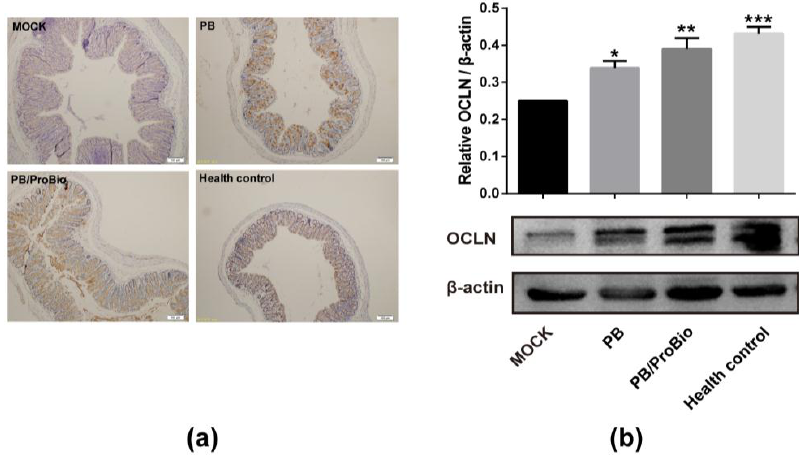
Figure 5. Protein expression of Occludin (OCLN) in different groups. ( a ) Immunohistochemistry analysis of the OCLN in colon. ( b ) Upper panel: Relative intensity of OCLN protein expression calculated as the ratio of OCLN vs. β-actin. Lower panel: Western blot analysis of OCLN in MOCK, PB, PB/ProBio, and Health control groups. * p < 0.05, ** p < 0.01, *** p < 0.001.